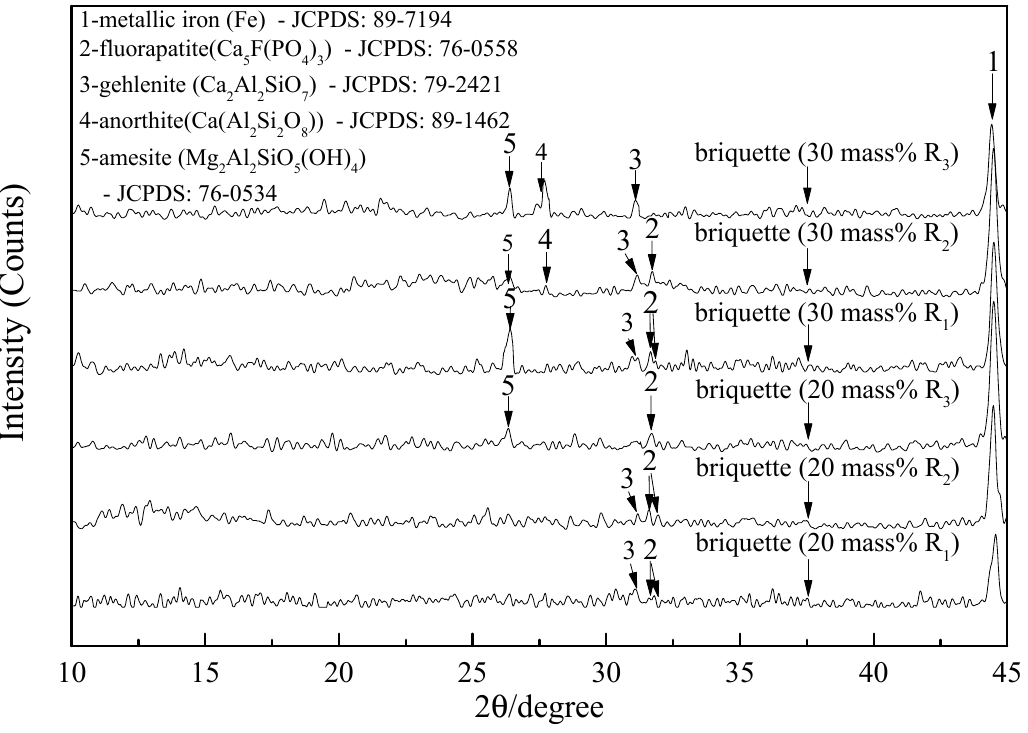
Figure 3. XRD analysis with JCPDS results of different briquettes.